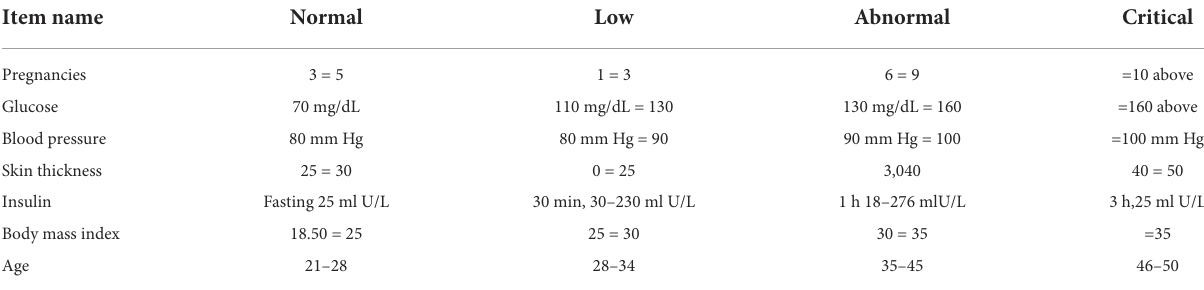
TABLE 1 Specifications of diabetes